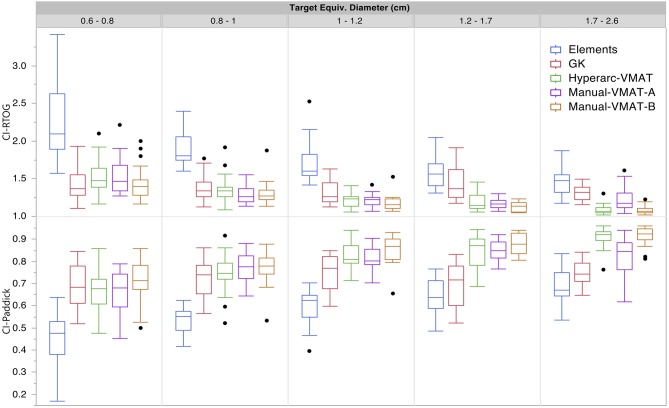
Conformity index results for both RTOG and Paddick definitions displayed as box plots per SRS plan type, divided into five separate target size diameter bins.